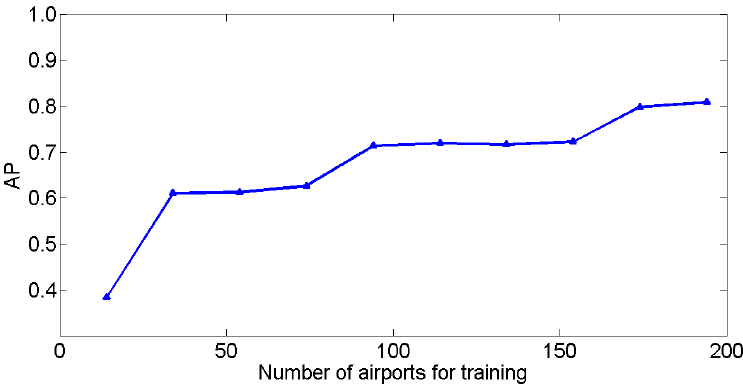
Figure 14. Performance of the proposed method with different number of training images.